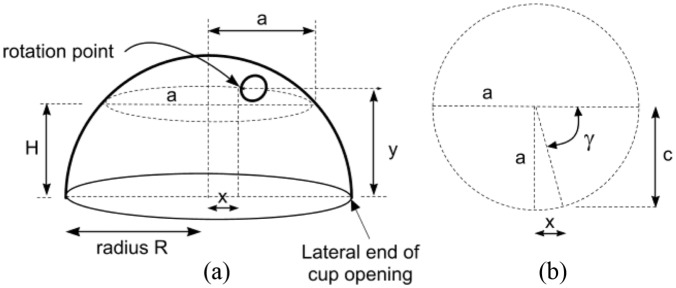
(a) The rotation point landmark is chosen to be at the edge of screw hole in the anterior surface of the shell image. (b) Circular view (from above the cup dome) of the cup section containing the rotation point landmark.